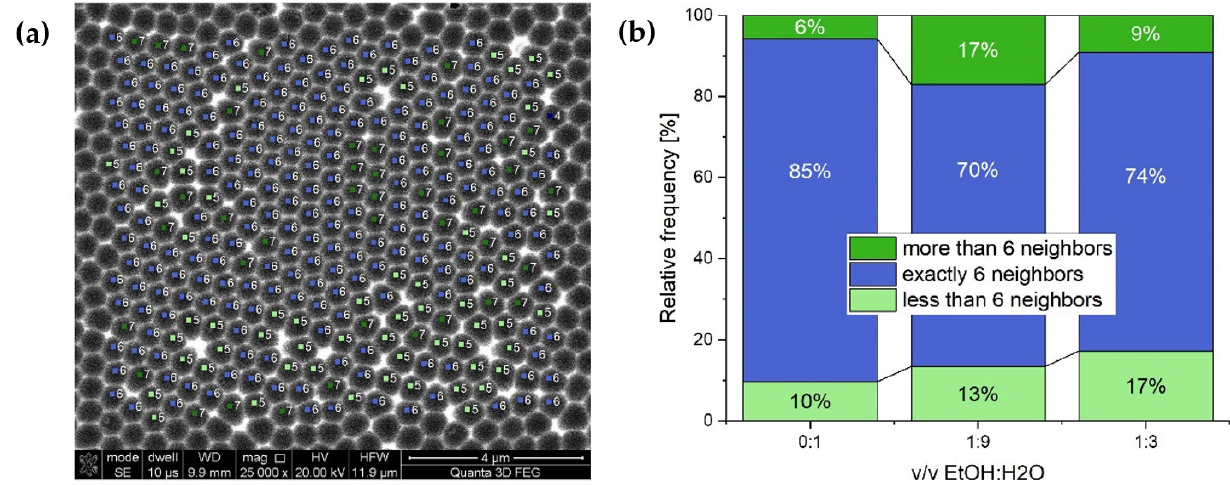
Figure 4. Presentation of the pore-ordering calculation method: blue—a pore with exactly six neighbors; light green—a pore with less than six neighbors; dark green—a pore with more than six neighbors ( a ); and the ordering degree pores after I anodization expressed as a relative frequency of the pores with 6, <6, and >6 nearest neighbors ( b ).